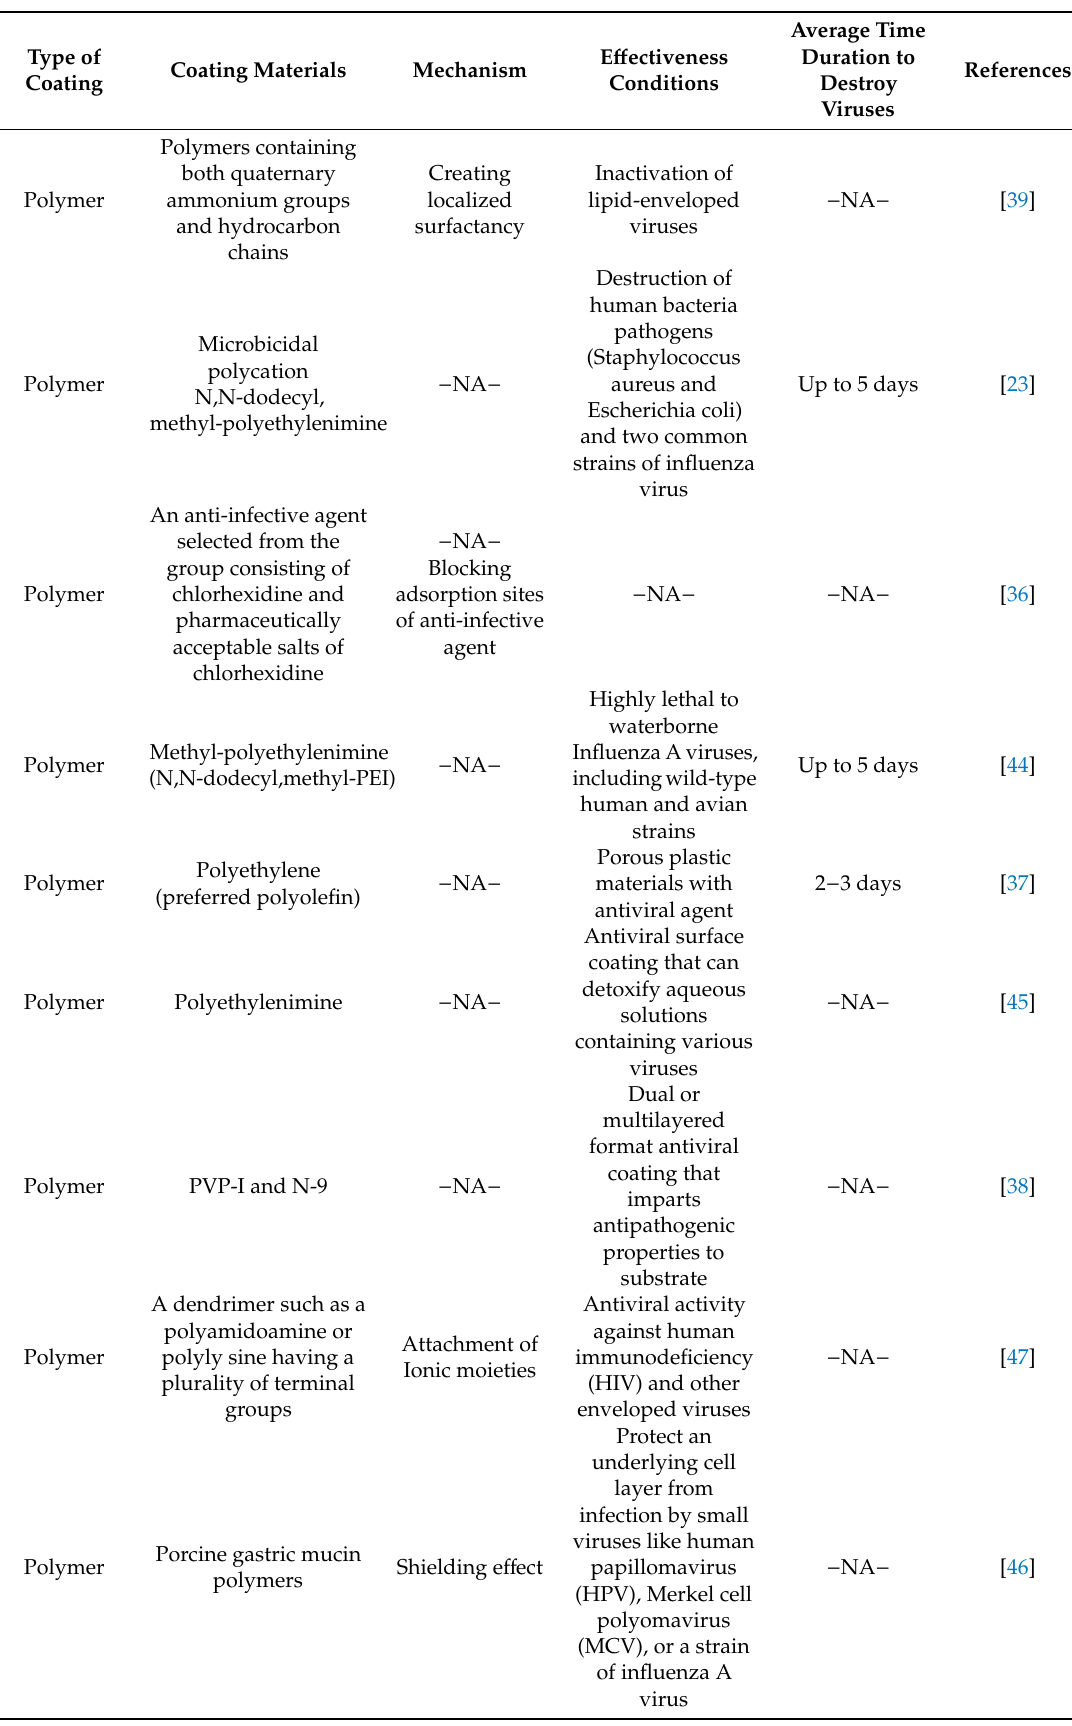
Table 1. Coatings used for antiviral and viricidal applications. NA: Not applicable. Type